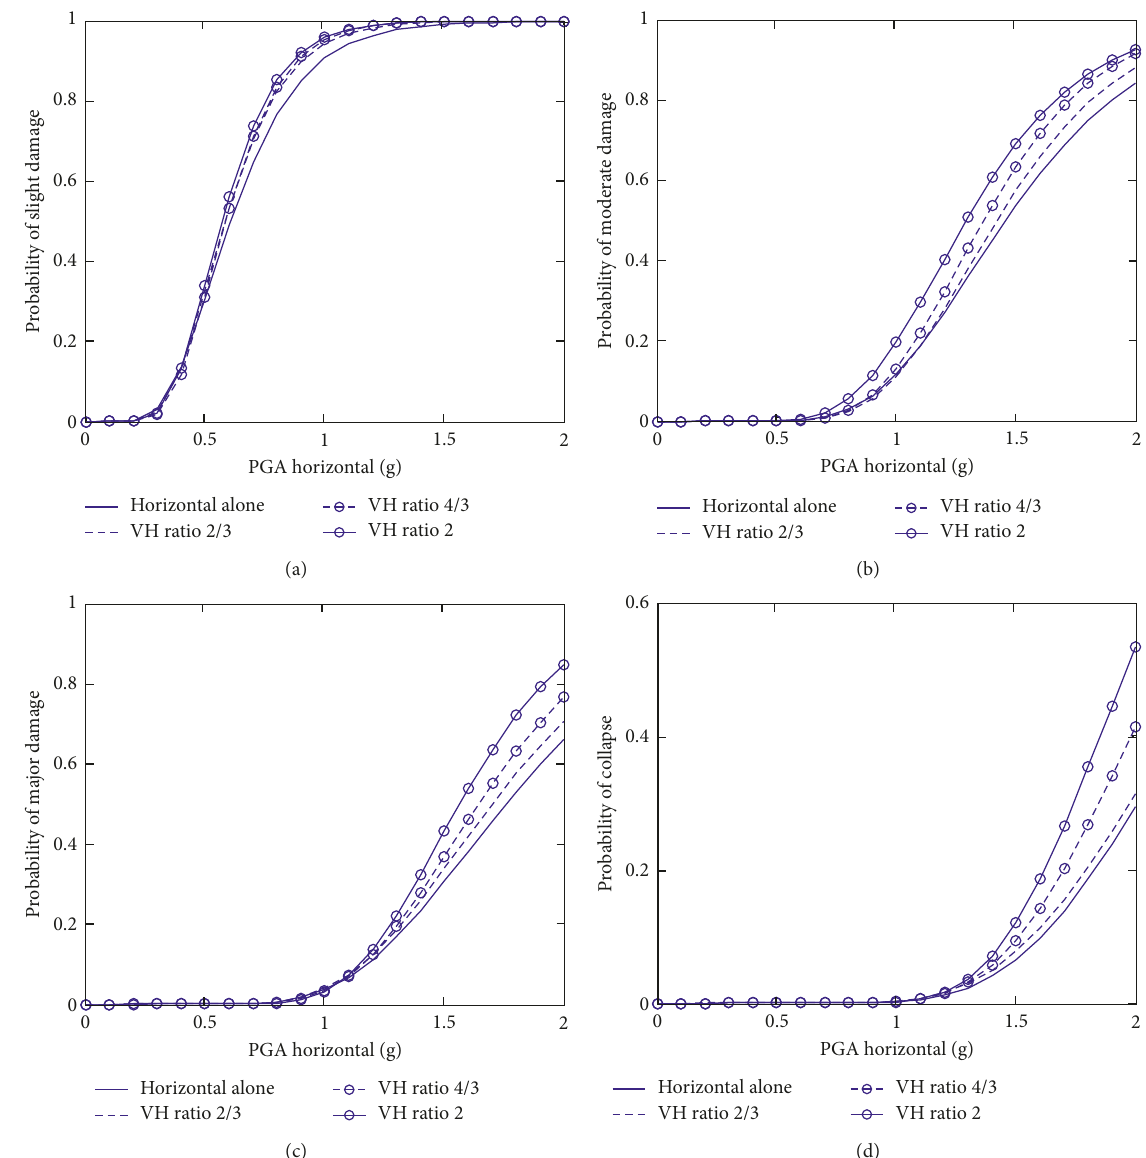
Figure 3: Fragility curves of the chimney structure for different damage states: (a) slight; (b) moderate; (c) major; and (d)